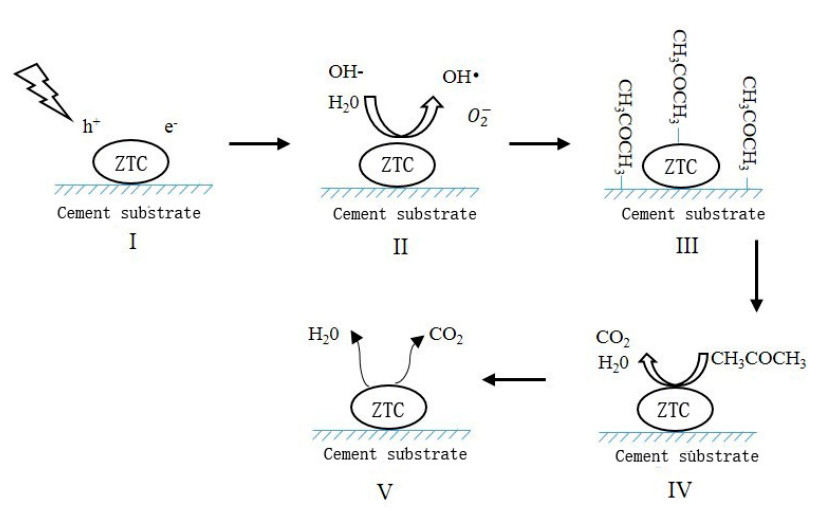
Figure 9. The kinetic processes of the degradation of acetone.